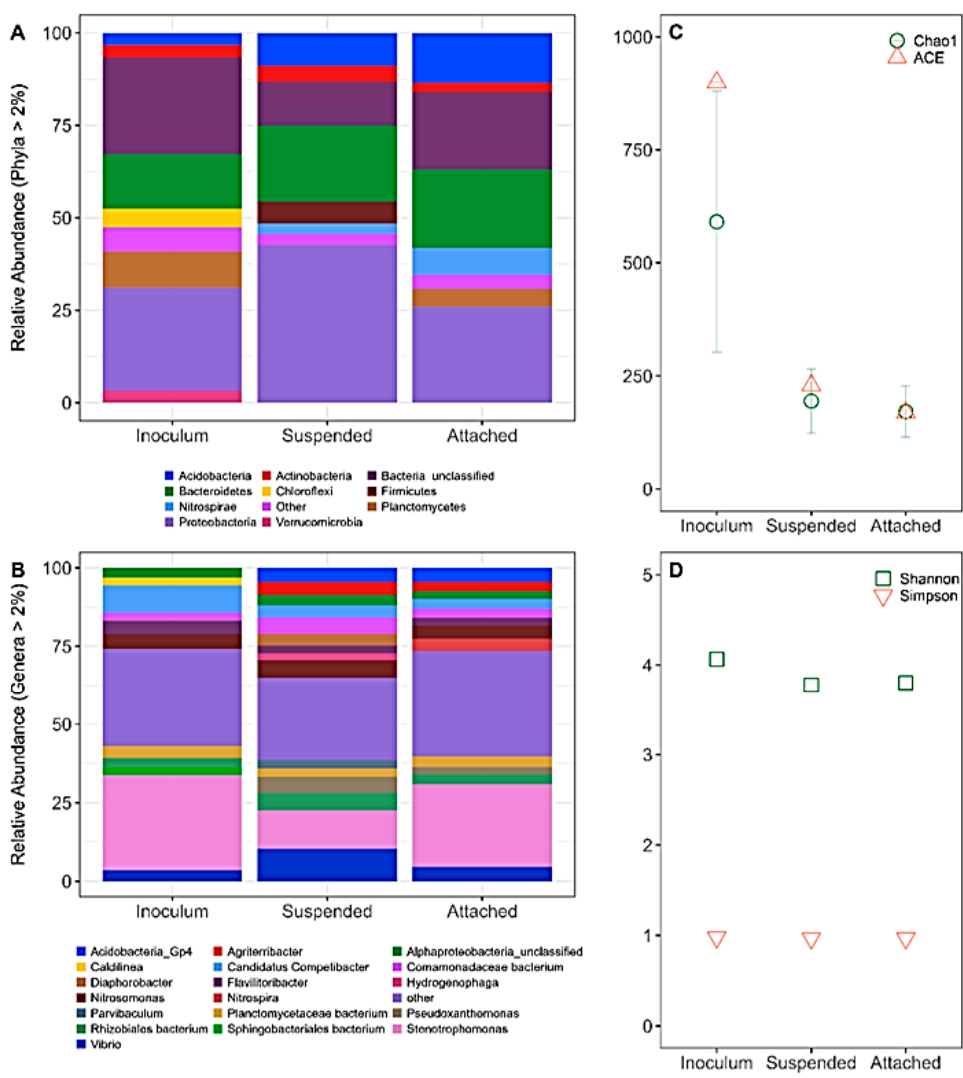
Figure 2. ( A ) Phylum level and ( B ) genus level relative abundance, ( C ) species richness, and ( D ) diver- sity indices of the original inoculum for both anode and cathode, suspended biomass in the cathode, and attached biofilm in the cathode after operating for 7 months. The “Other” legend key represents the aggregate of all taxa level identification with a relative abundance < 2%. ACE = abundance-based coverage